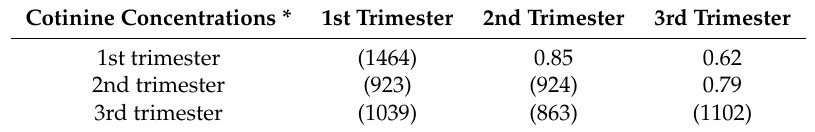
Table 2. Correlations between cotinine concentrations in the first, second and third trimesters of